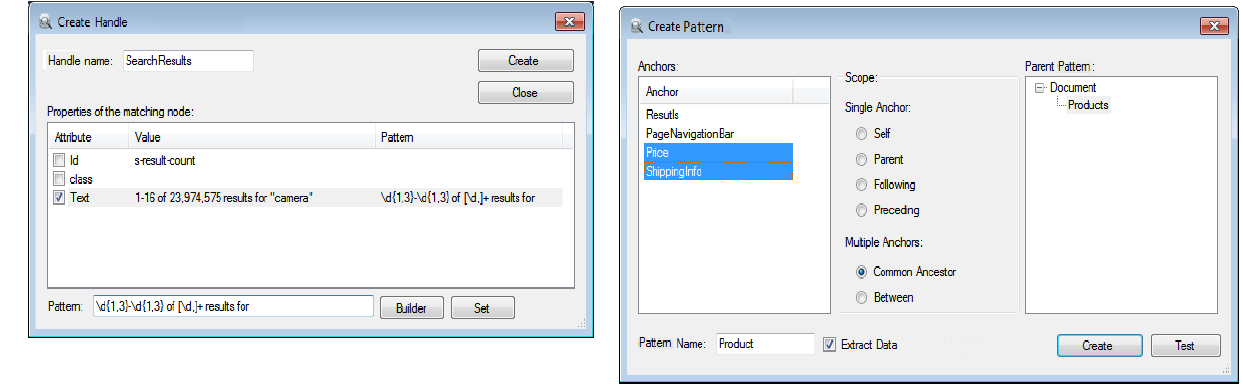
Figure 4. Screenshot of dialog boxes for creating handles (left) and patterns